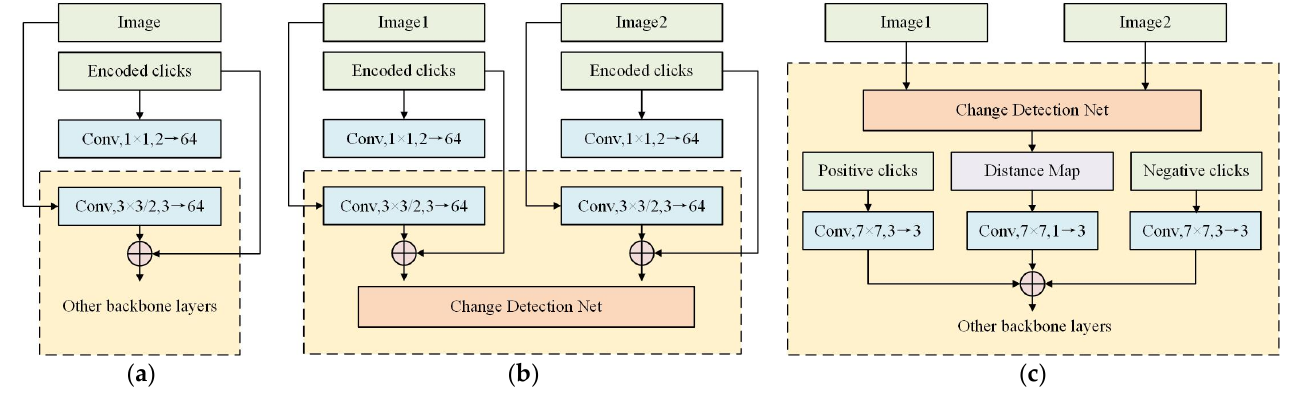
Figure 3. Methods of fusing clicks. ( a ) Conv1S; ( b ) merge at the beginning; ( c ) merge at the distance map.